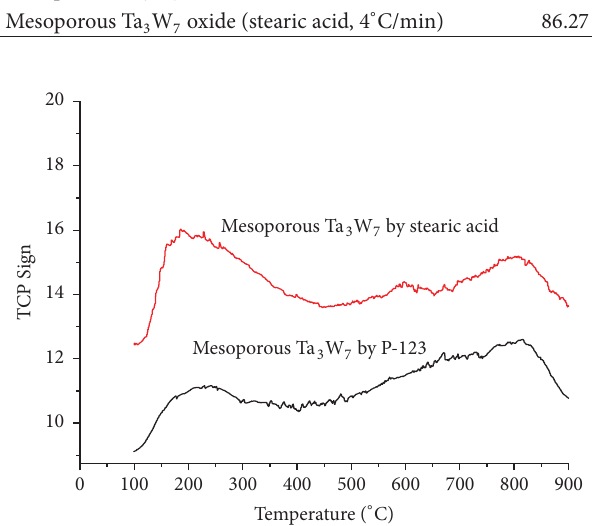
Figure8:NH 3 -TPDcurvesofmesoporousTa 3 W 7 oxide(P-123)and mesoporous Ta 3 W 7 oxide (stearic acid).